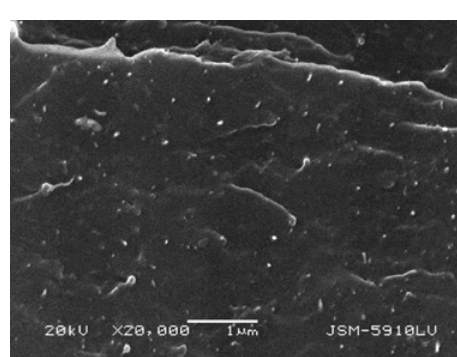
Figure 10 Electron transfer through “C1” specimen during volume resistivity test.